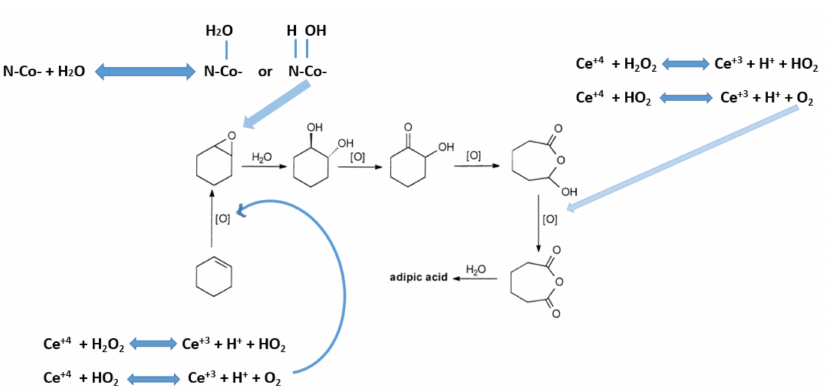
Figure 11. The reaction mechanism for the oxidation of cyclohexene with ZIF-67/CeO 2 as a